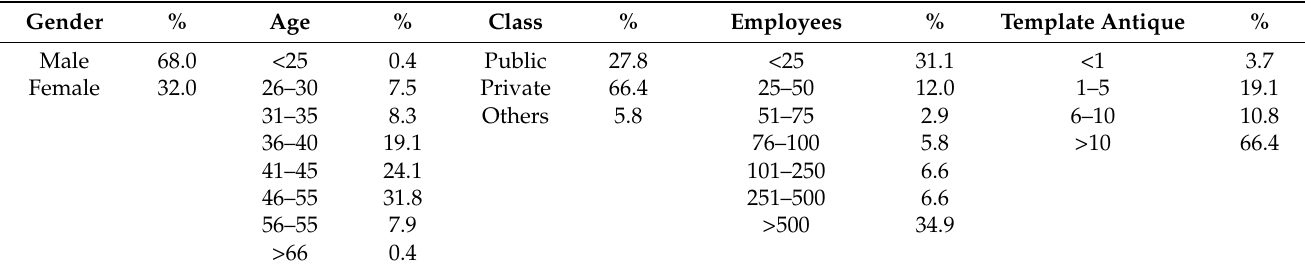
Table 1. Sociodemographic profile and characteristics of the